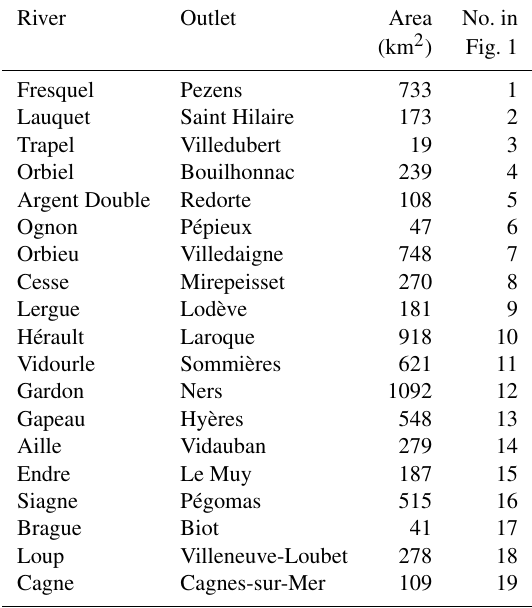
Table 1. Characteristics of the studied